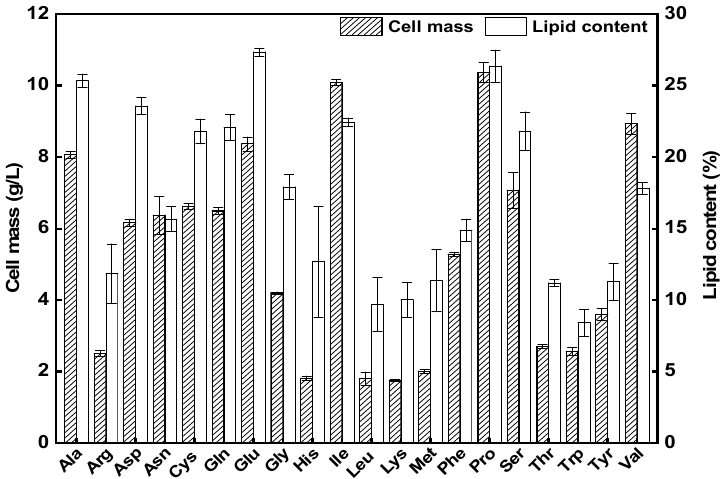
Figure 1. Lipid production results for R. toruloides CGMCC 2.1389 with each AA.